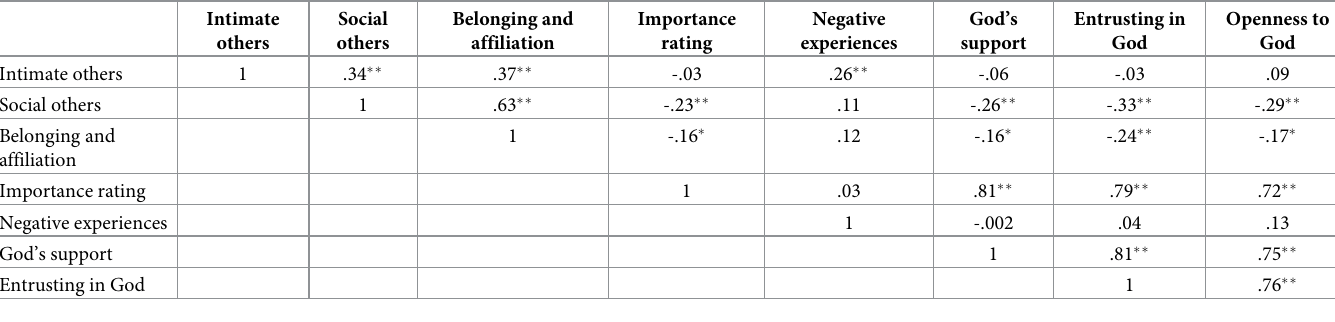
Table 1. Pearson correlations among religious experience scales and loneliness